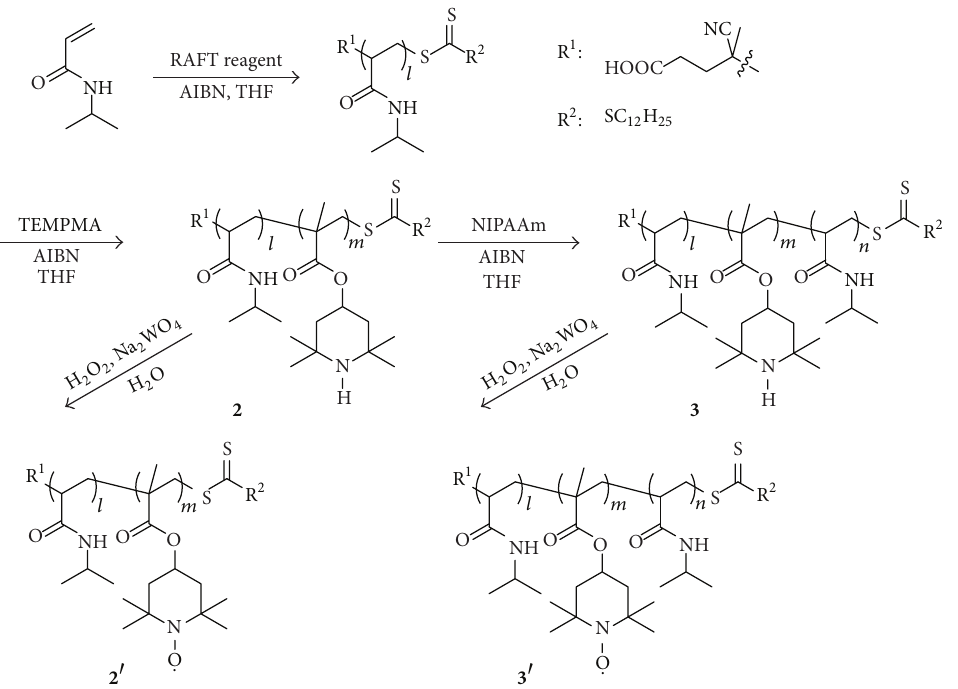
Scheme 2: Synthesis of the block polymers consisting of NIPAAm and TEMPOMA